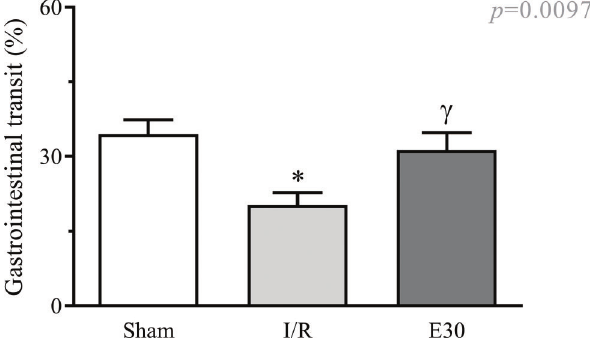
Figure 1 - Effect of intestinal I/R injury on the gastrointestinal transit (%). In rats with I/R injury, the superior mesenteric artery was clamped (45 min), followed by intestinal reperfusion (2h). Estradiol (180 m g/kg, i.v.) was administered 30 min after the induction of intestinal ischemia (E30). Sham-operated rats were used as controls. Data are expressed as the mean ± standard error of the mean (SEM) from 6 animals. * p =0.011 compared with the sham group; g p =0.0457 versus intestinal I/R group. I/R, ischemia and